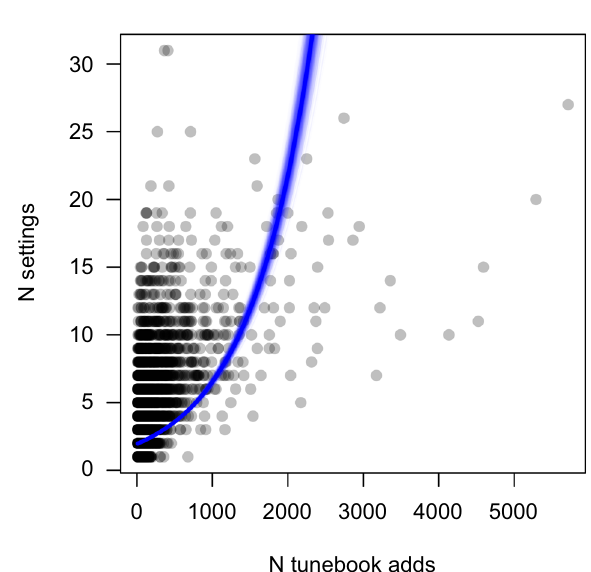
Fig. 1 Scatterplot showing the relationship between richness ( N settings) and popularity ( N tunebook adds), across Session tunes ( n = 9378). The shaded area is made up of fi t lines from the entire posterior distribution, while the thick line is based on posterior mean effects. Fit lines were calculated with the time since tunes were uploaded to the site fi xed at the median